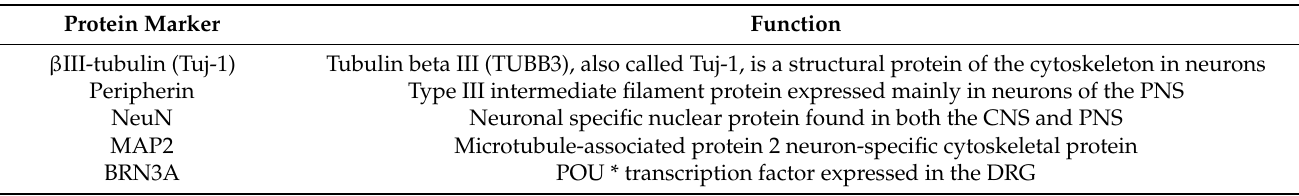
Table 3. Commonly used protein expression markers of differentiated peripheral sensory neurons [22]. Protein Marker Function β III-tubulin (Tuj-1) Tubulin beta III (TUBB3), also called Tuj-1, is a structural protein of the cytoskeleton in neurons Peripherin Type III intermediate filament protein expressed mainly in neurons of the PNS NeuN Neuronal specific nuclear protein found in both the CNS and PNS MAP2 Microtubule-associated protein 2 neuron-specific cytoskeletal protein BRN3A POU * transcription factor expressed in the DRG * The acronym, POU, is derived from the names of three transcription factors: (1) the Pituitary-specific Pit-1, (2) the Octomer-binding proteins Oct-1 and Oct-1, and (3) the neural Unc-86 transcription factor from Caenorhabditis elegans